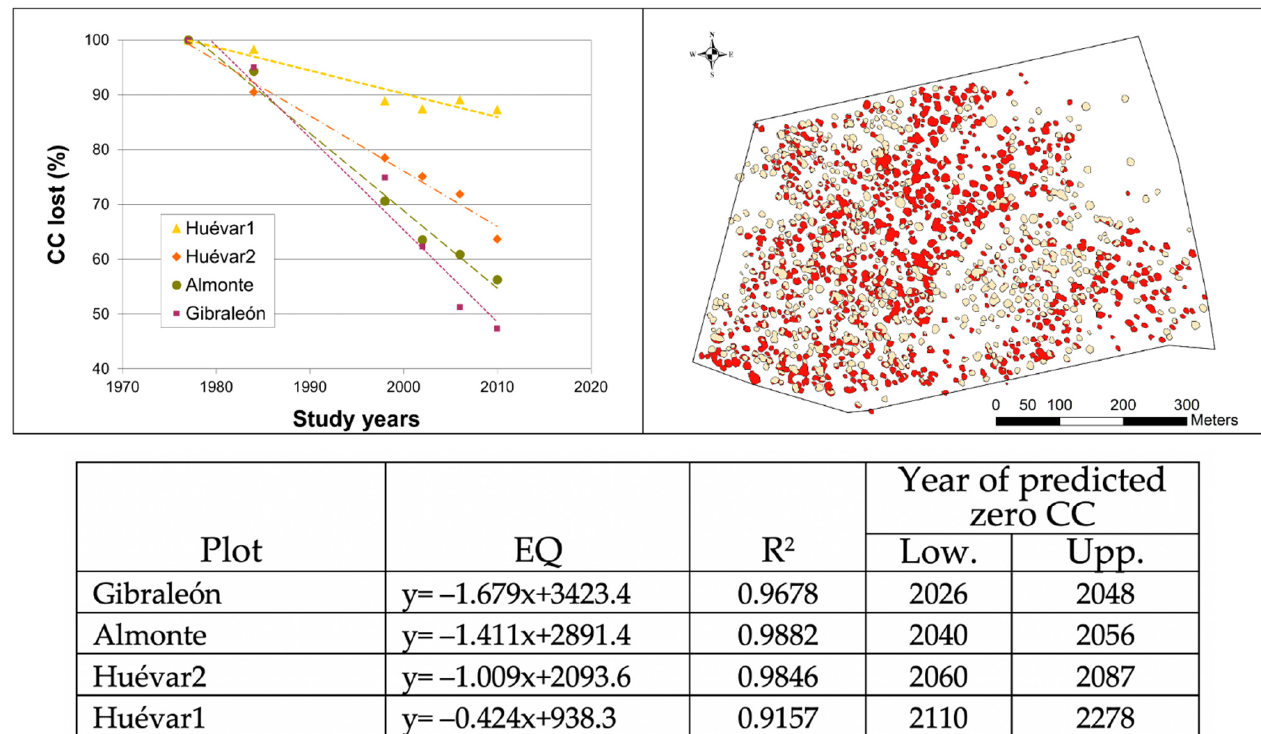
Figure 3. Canopy cover decline. Top left: canopy cover loss by percentage in the four study plots since 1977. Top right: Canopy cover loss in Gibrale ó n; red polygons represent remaining canopy in 2010; clear polygons represent remaining canopy in 2010. Bottom: Equations predicting year of total canopy cover; R 2 ; lower (Low) and upper limits (Upp) of zero value at the current rate of loss. Taking into account the updated data from 2018, the loss of canopy cover slows down and even reverses (in all sites except Gibrale ó n) from 2010, although the decrease in the number of polygons continues in all plots. According to the model that best fits the entire data set (Year = CC + number of polygons), the degradation of plots detected up to 2010 remains linear until 2018 (adjusted R 2 > 0.95, p < 0.001 in all cases). If we extrapolate the trend observed for the plot to the entire site, the whole Gibrale ó n stand would be lost within a maximum period of just over 20 years, while Almonte would be lost within the next 30 to 100 years. With respect to the Hu é var site, this could disappear within the next 50–80 years, if the overall evolution follows the pattern detected in the Hu é var plot2; alternatively, it could have a much longer period of decline (140–270 years) should it follow the pattern in Hu é var1 (Figure